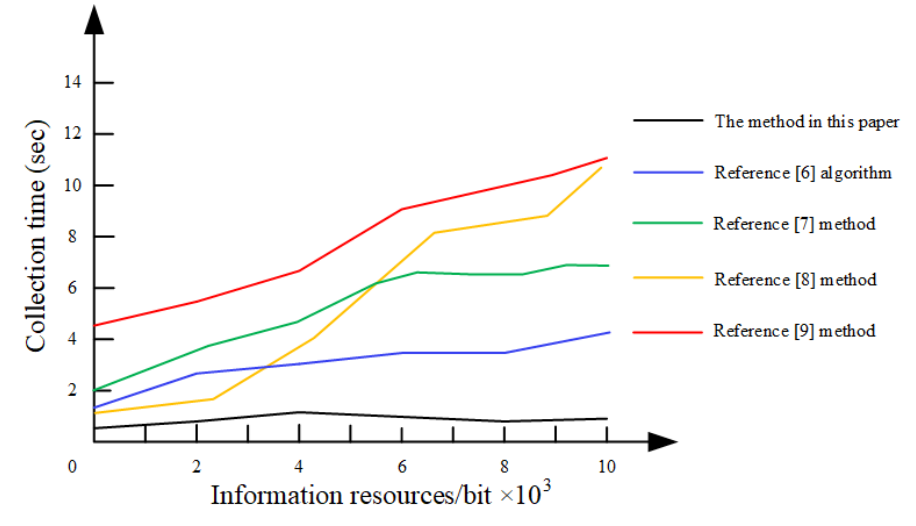
Figure 3. SPI collection time.